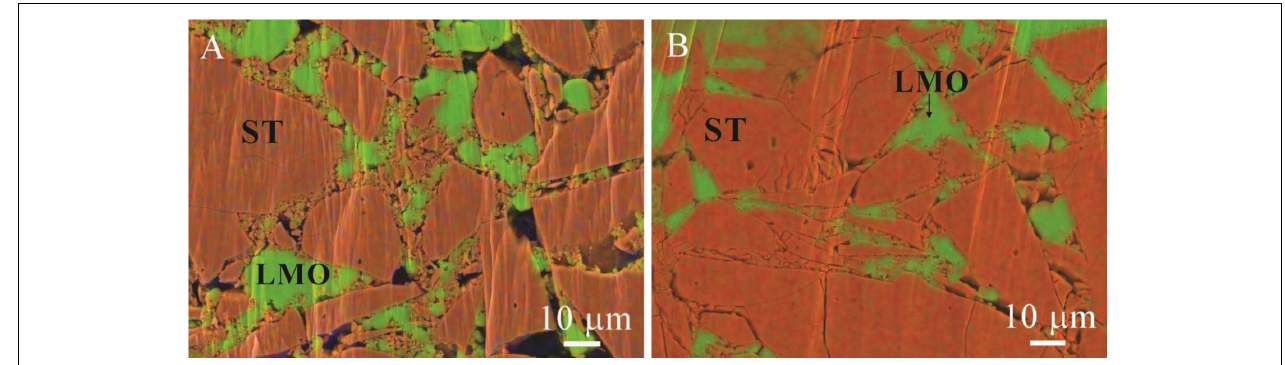
FIGURE 9 | SEM micrographs of the LMO-ST composite pressed (A) at 130 MPa and (B) at 1,000 MPa. Green color represents LMO phase, while orange color corresponds to